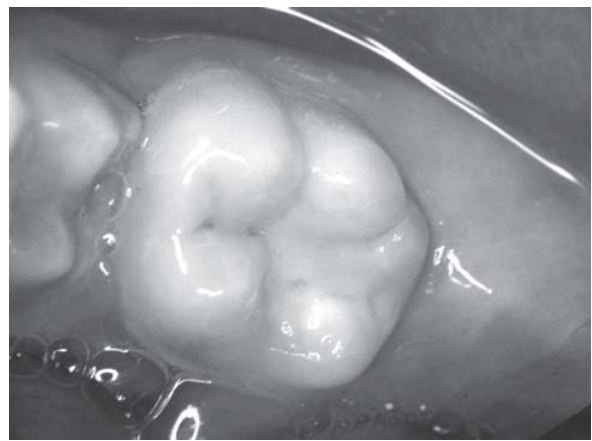
Figure 5- Cavity prepared, just after caries excavations and cavity cleaning